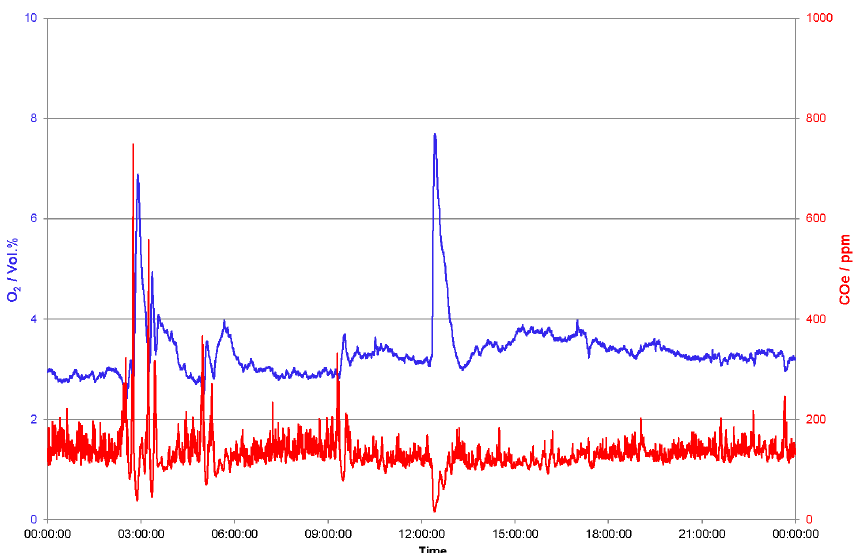
Figure 4. Oxygen and CO concentrations from the kiln inlet over a full day (upper curve oxygen, the lower one